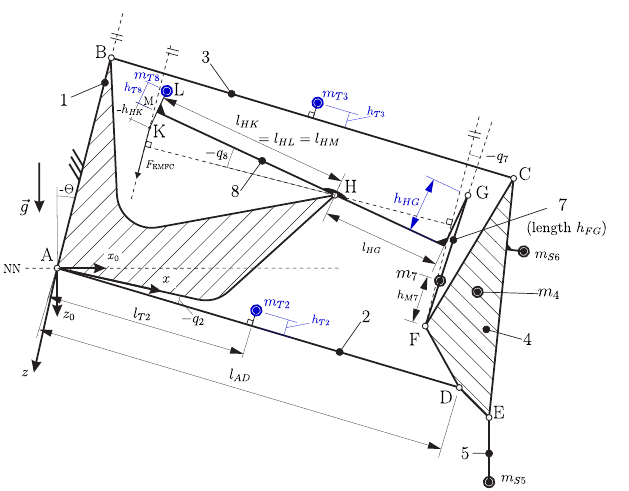
Figure 2. Rigid body model of the deflected weighing cell ( q 8 ) with a tilted base (body 1) with respect to g ( (cid:50) ). Body 6 is a sample weight on the upper weighing pan ( m S 6 ) rigidly coupled to body 4. The three adjustable parameters h T 2 = h T 3 , h T 8 and h HG are highlighted in